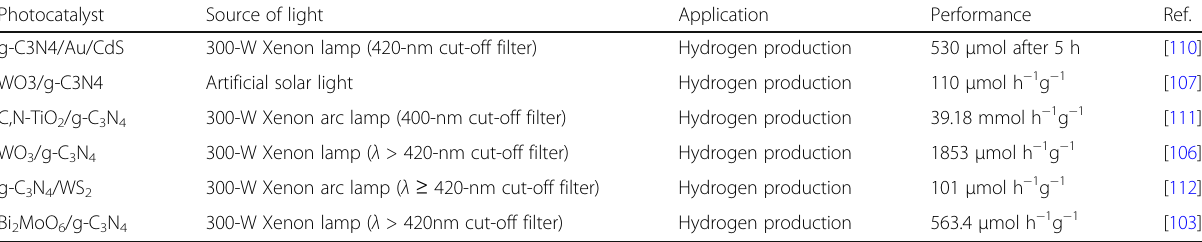
Table 2 Hydrogen production study by different g-C3N4